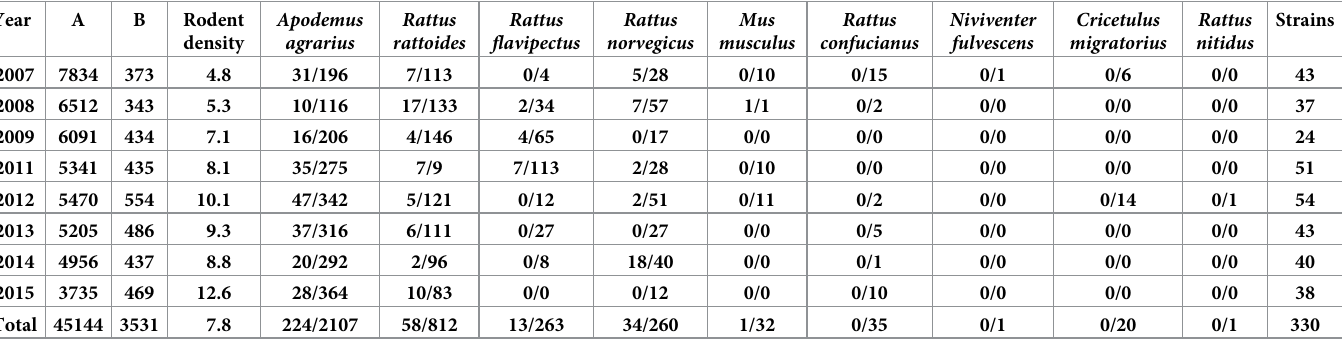
A-Number of total traps placed for each year. B-Number of rodents trapped for each